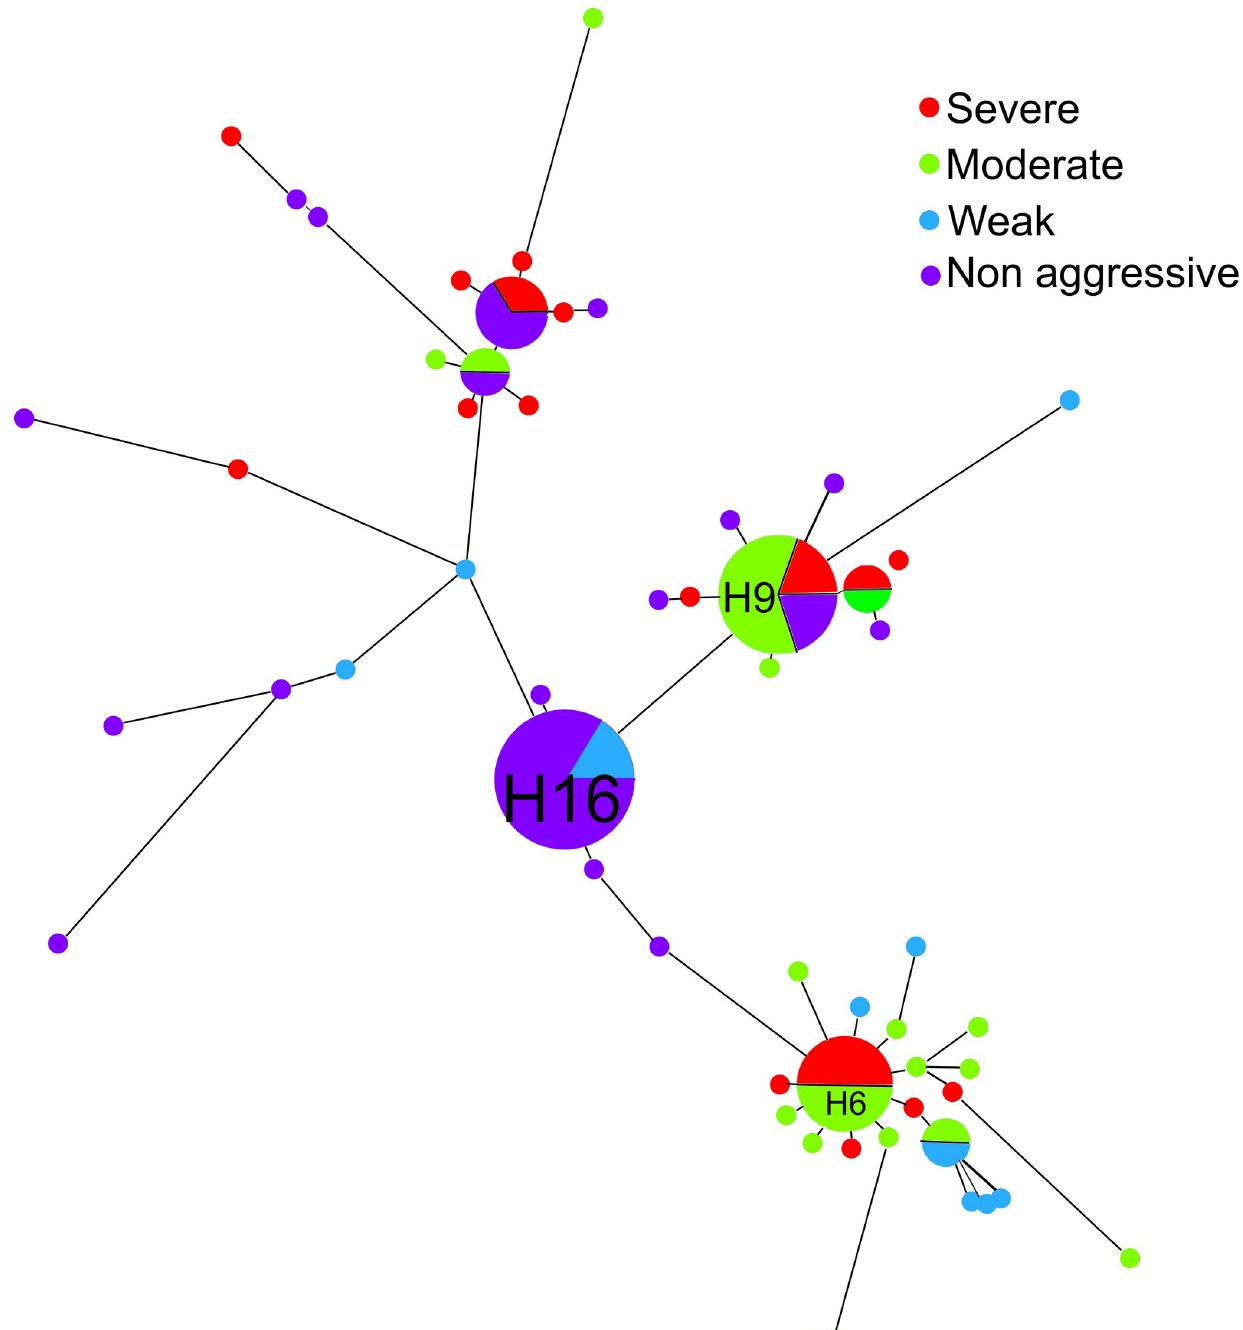
Fig 3. Haplotype network derived from concatenated sequencing data of BT, IGS, ITS, and TEF genes and loci and color-coded for level of aggressiveness (non-aggressive, weak, moderate, severe) of Fusarium oxysporum f. sp. niveum isolates. The connecting lines are proportional to number of mutations between